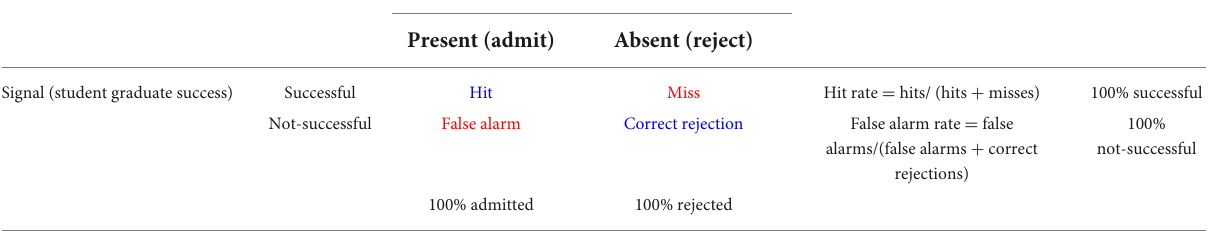
TABLE 1 The pay-off matrix of signal detection theory (SDT) applied to admission decisions.